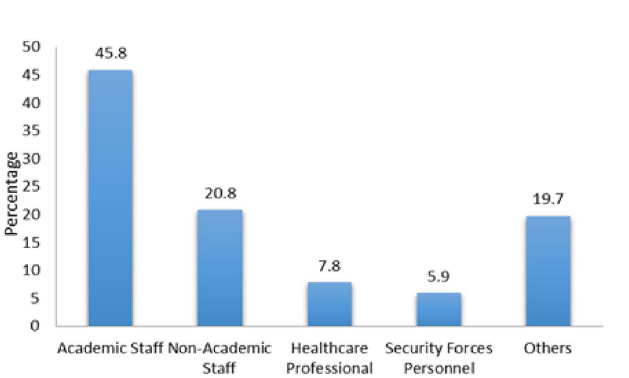
Figure 3. Percentage of qualification wise responses. The bar chart represents percentages of respondents having different qualifications.